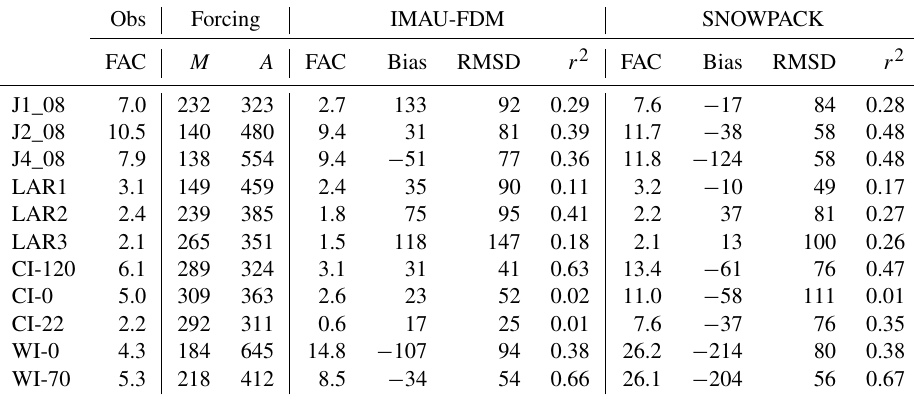
Table 2. Mean, bias (model – observation), RMSD, and correlation coefficient ( r 2 with significance level p < 0 . 0001) of density profiles for the 11 firn cores described in Table 1. Denoted are also observed and modelled firn air content (FAC; in metres) and the annual average melt ( M ; mmw . e . yr − 1 ) and accumulation ( A ; mmw . e . yr − 1 ) forcing. Both modelled and observed density profiles are vertically interpolated on a regular vertical grid, and statistics are based on this